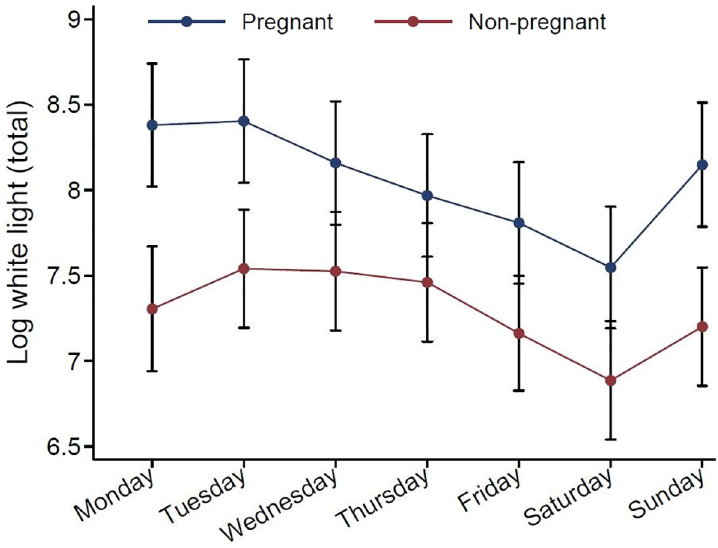
Fig 3. Daily evening light exposure, in pregnant and non-pregnant women. Estimated by linear mixed effects models including group-by-weekday interaction. The p value for time-by-group interaction was p = .307 derived from actigraphy for total white light (log transformed).